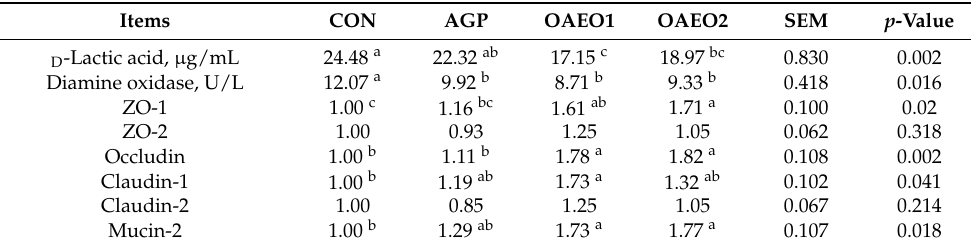
Table 5. Effect of OAEO on gut barrier integrity-related genes mRNA levels, and serum D -lactic acid content and diamine oxidase activity of